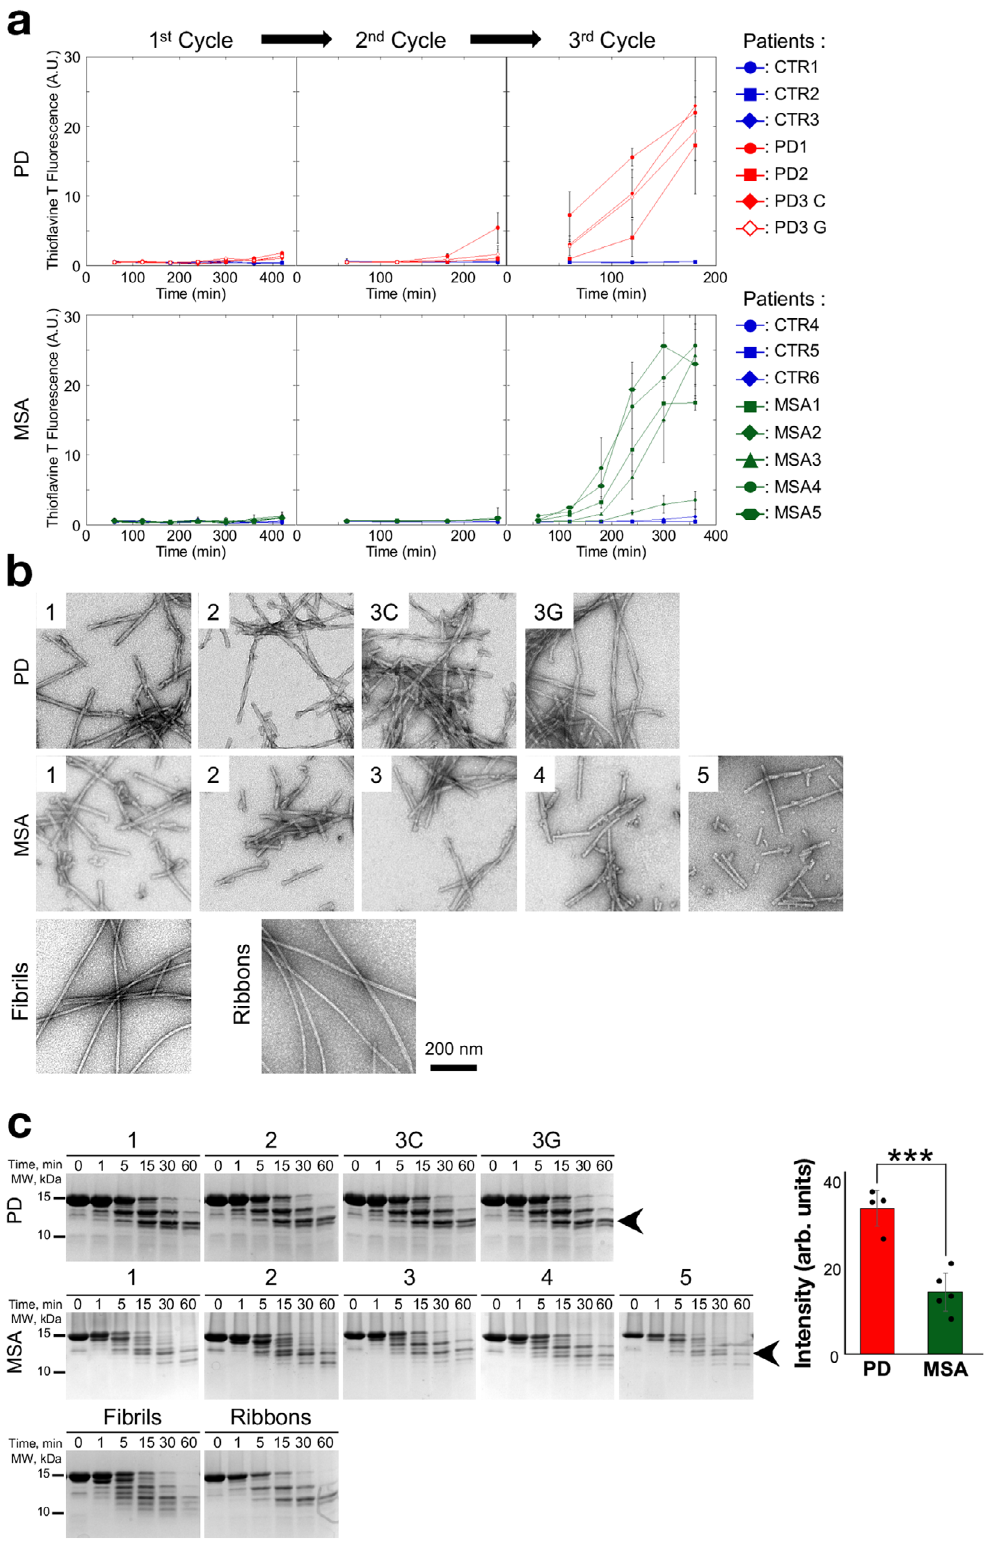
patients for cycle 3) in assembly buffer containing monomeric α - synuclein. We found that homogenates from the three PD and fi ve MSA patients but not the control patients exhibited seeding propensity (Fig. 2a). The resulting α -synuclein assemblies were imaged by transmission electron microscopy (TEM) and fi nger- printed by SDS-PAGE after limited proteolysis using Proteinase